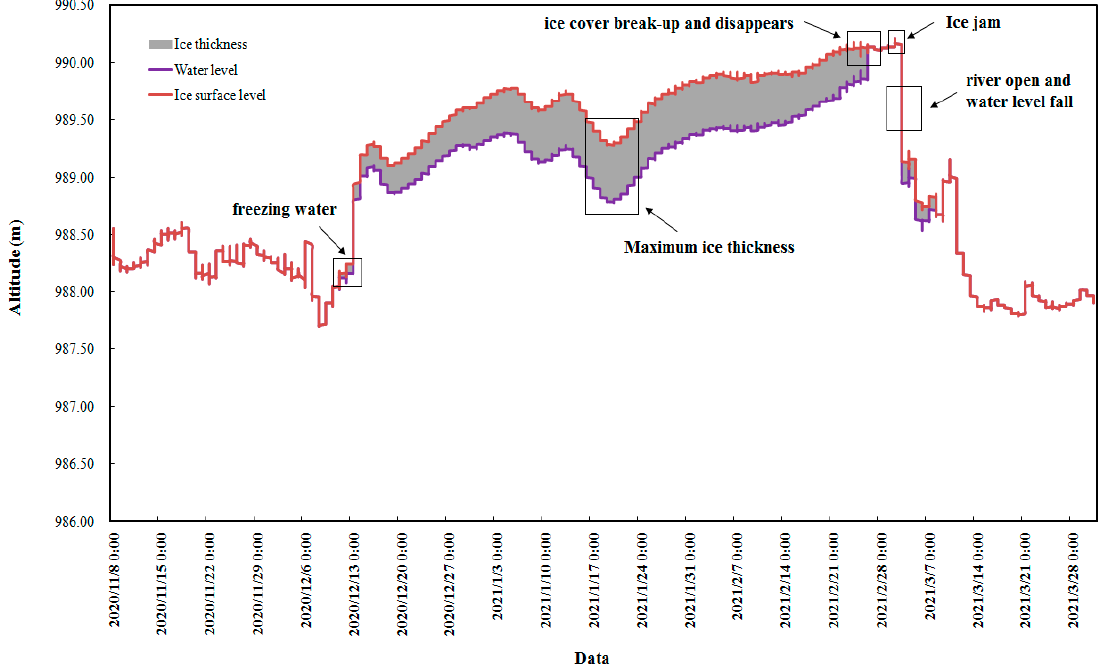
Figure 11. Ice thickness and water level in different times of the Shisifenzi reach in the 2020–2021 ice period.